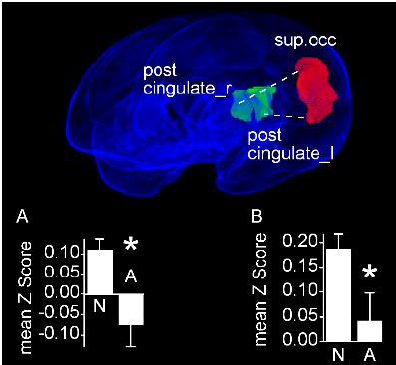
Figure 5. Region pairs exhibiting increased and decreased functional connectivities in infants with normal movement character compared with infants with stiff movement character. Obliquely projected 3D reconstructions of MRI images of cerebral grey matter and identified parcellated regions derived from a neonatal atlas. The left superior occipital cortex exhibits an increased rsFC with both posterior cingulate gyri. Dashed white lines depict connectivity relationships. Insets: Fisher-transformed Z-scores ± 1 SEM. ( A ) Left superior occipital cortex and right posterior cingulate cortex. ( B ) Left superior occipital cortex and left posterior cingulate cortex. N: Normal; A: Abnormal. * P FDR < 0.05.